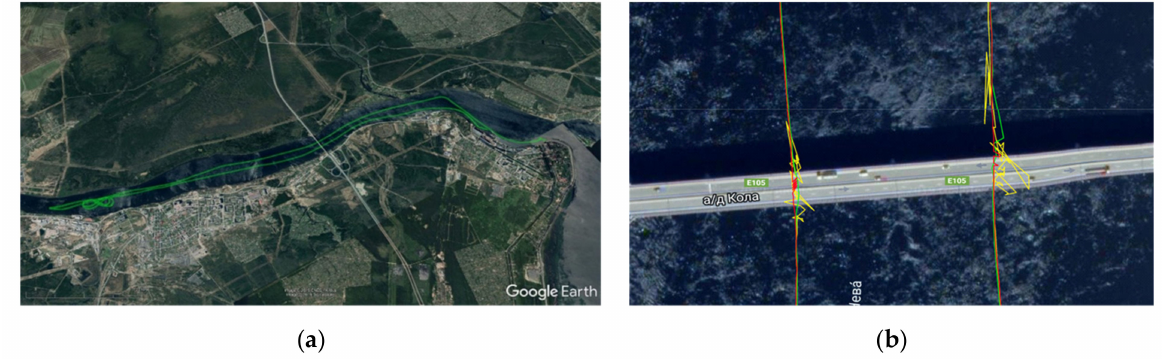
Figure 2. Total path of the ship ( a ), the part of the path near and under the bridge ( b